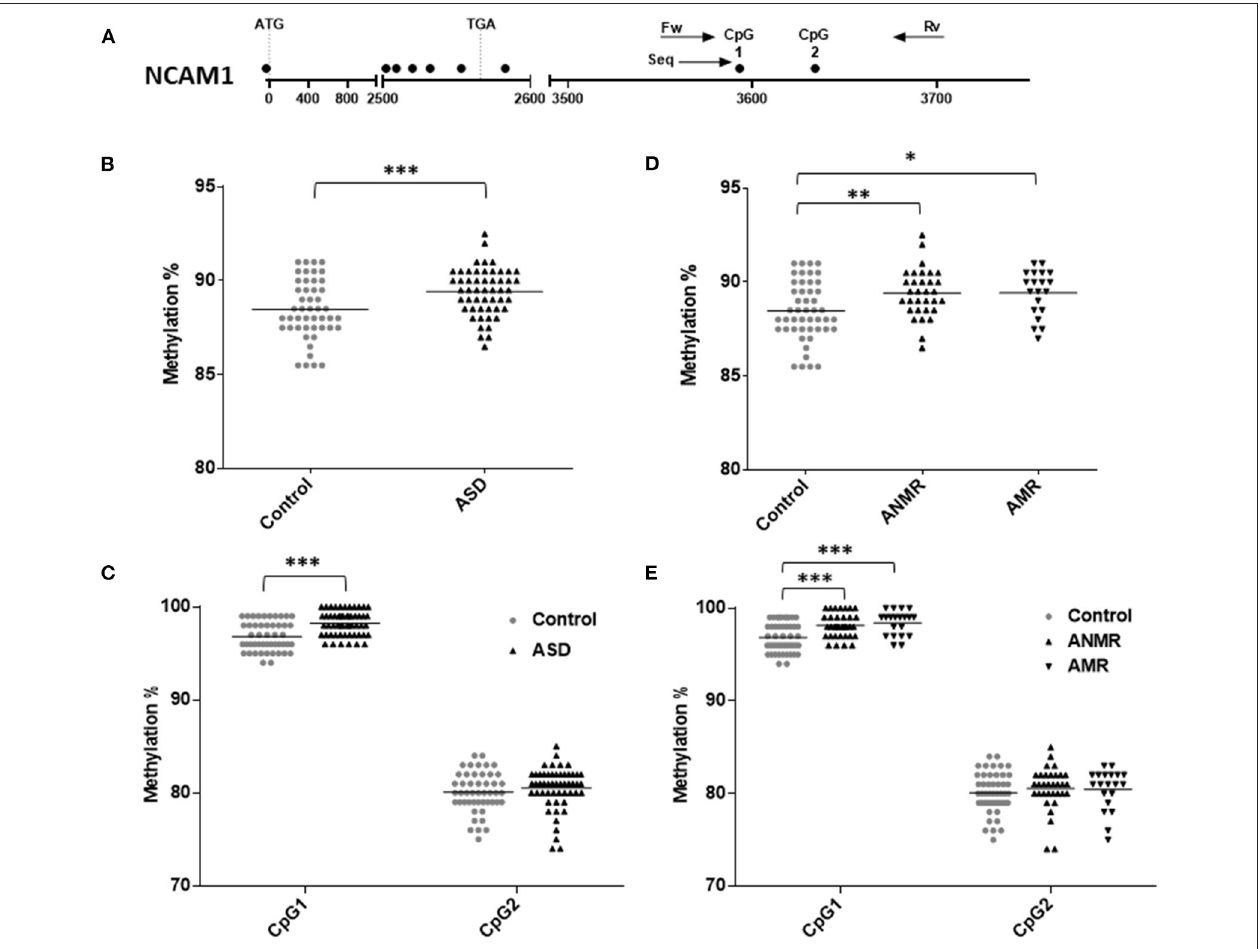
FIGURE 2 | Scatter plot showing comparisons of methylation status of NCAM1 in children with autism spectrum disorders (ASD) compared to controls. (A) Schematic diagram of analyzed gene. Each circle represents a CpG dinucleotide. Position of ATG and TGA codon are indicated. Arrows show the location of pyrosequencing primers. (B,C) Methylation levels and differentially methylated sites (CpG1 and CpG2) in the NCAM1 gene in ASD group and healthy control group. (D,E) Methylation levels and differentially methylated sites in the NCAM1 gene in ASD group subdivided as follows: ANMR (non-mental regression group), AMR (mental regression group), and a healthy control group. The dark bars represent the mean values of each group. Asterisks indicate statistically significant differences (* P < 0.05; ** P < 0.01; *** P < 0.001) compared to control group.